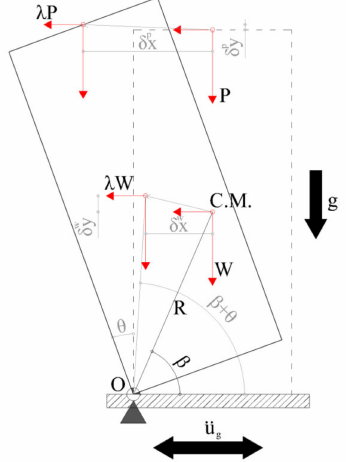
Figure 3. Rocking of a tower at its